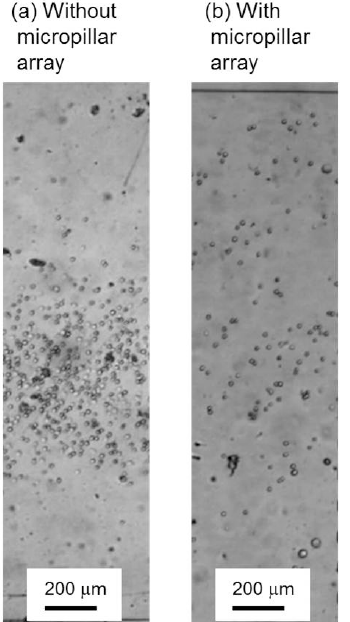
Figure 13. Images of N87 cells introduced into microchamber. ( a ) Microchamber without micropillar array. The cells are concentrated in the center of the microchamber. ( b ) Microchamber with micropillar array. The cells are uniformly